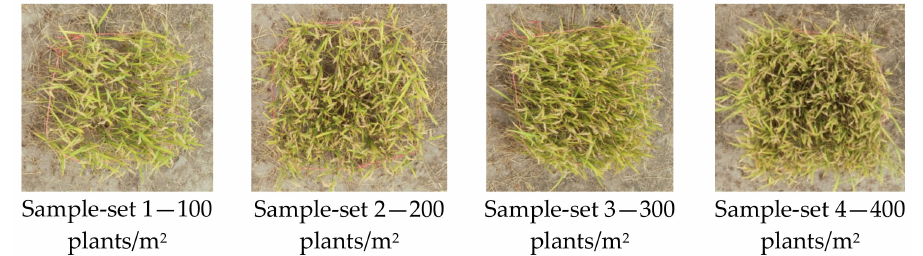
Figure 2. Standard experiment group with manually set densities rice samples.